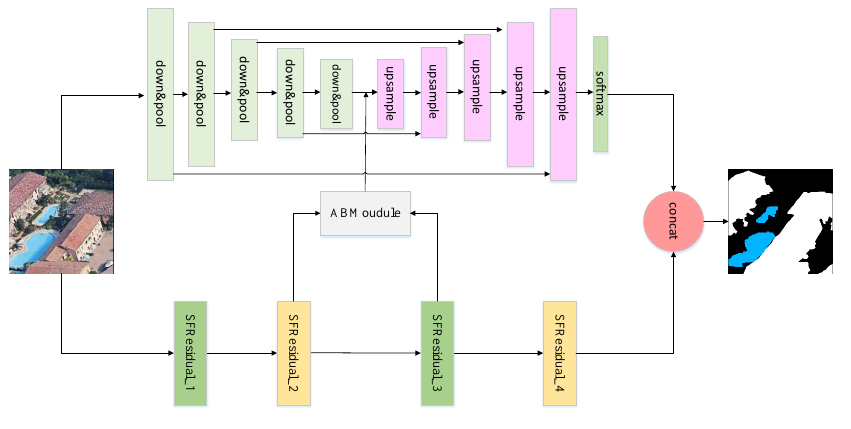
Figure 1. Diagram of the structure of MSNet.